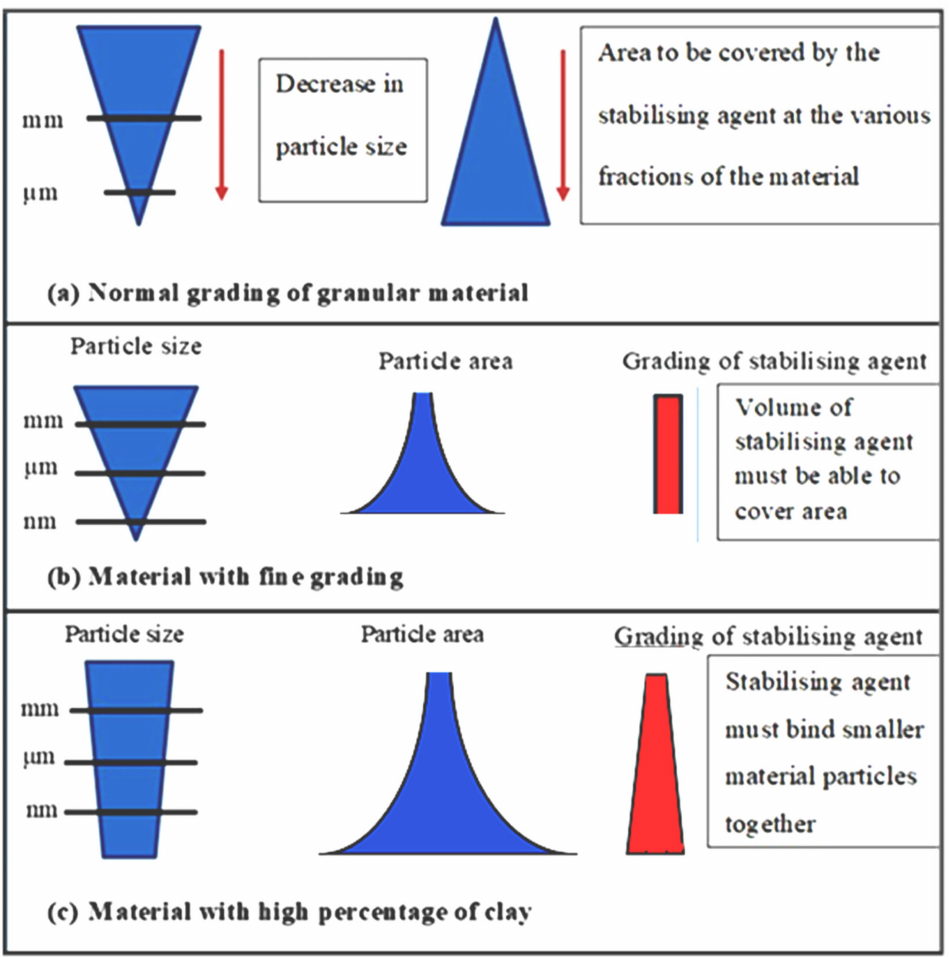
Figure 13. Illustration of grading of material (particle size) versus area to be covered by an applicable stabilising agent and required particle size of the stabilising